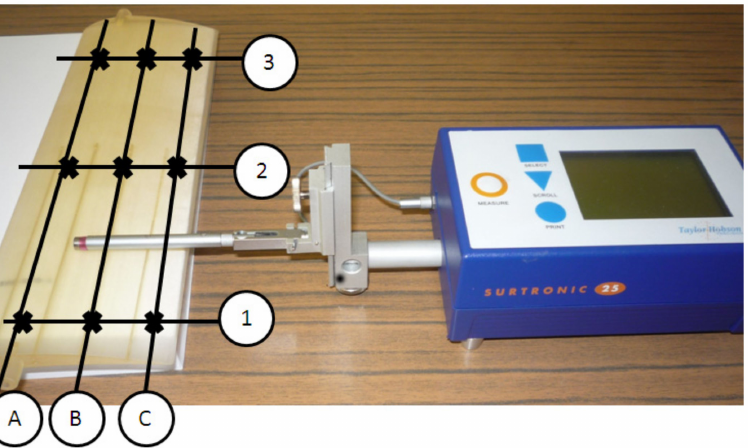
Figure 8. Measurement scheme of the airfoil roughness. Surface roughness measurement of the upper